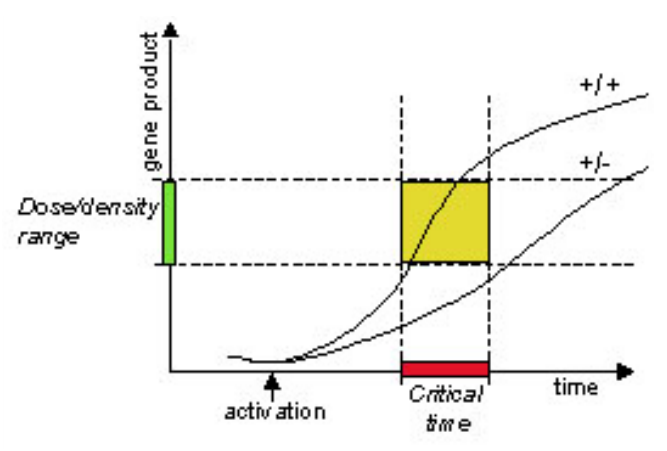
FIGURE 2. Schematic drawing illustrating a model of integration of temporal and dosage requirements for a given developmental process in a specific cell population. The assumption, supported by experimental data, is that the gene product (e.g., Tbx1) has only a limited time to effect its function. The “dose/density range” refers to the minimum concentration of gene product in a cell population required for the developmental process to occur normally. The deletion of one copy of the gene may increase the time necessary for the gene product to reach a particular concentration, as predicted by models of stochastic gene